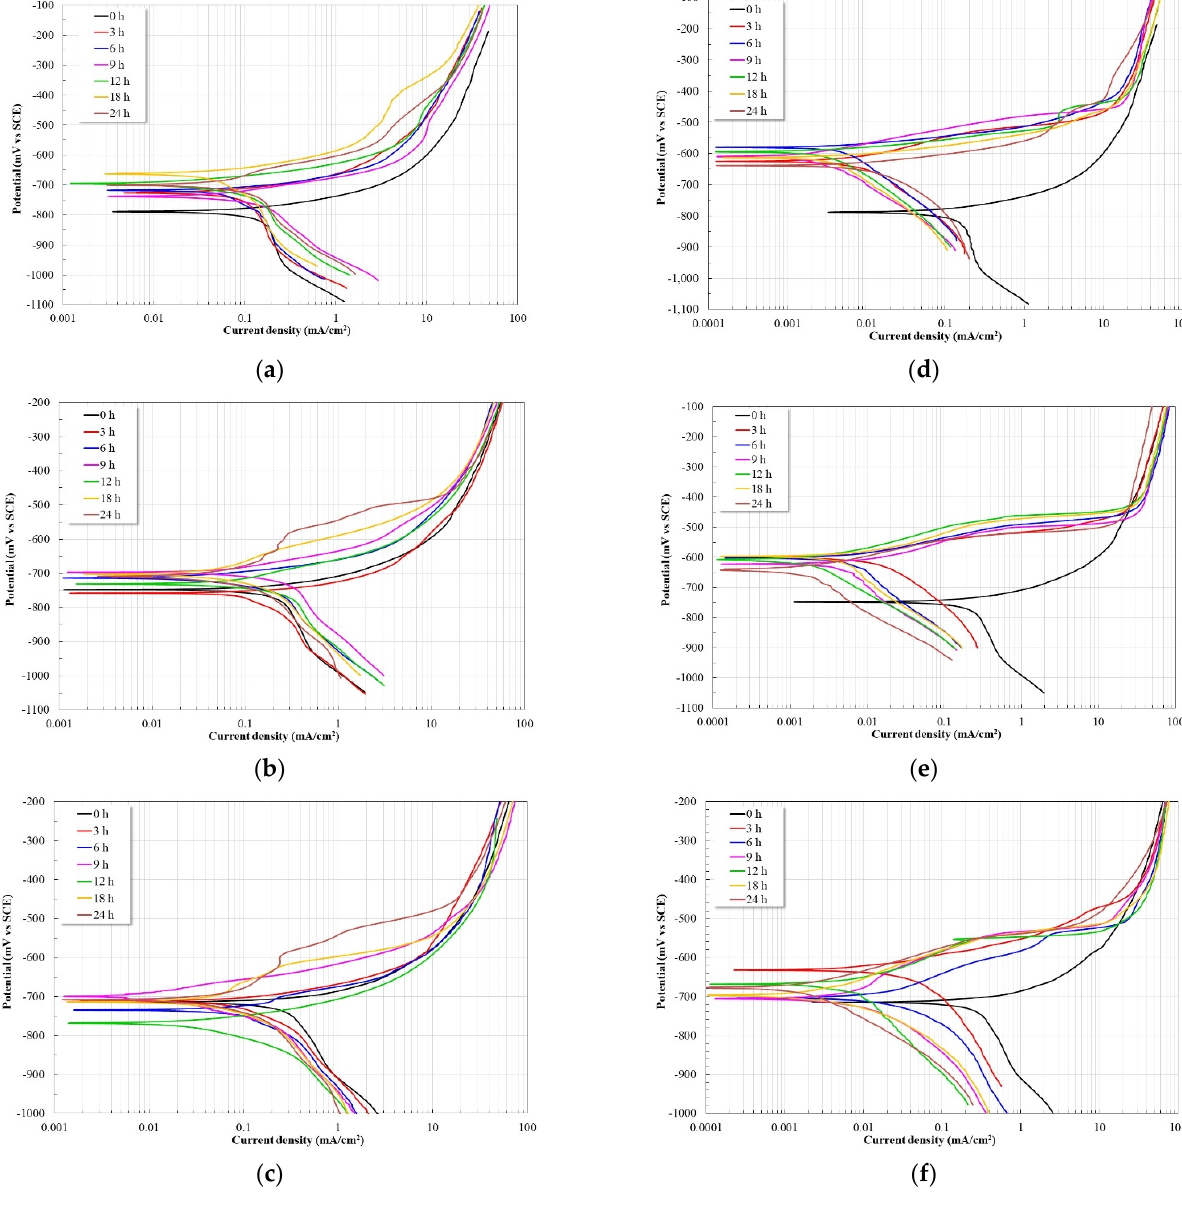
order of magnitude lower). These changes show that the inhibitor has adsorbed on the surface of the working electrode acting as a barrier between the electrolyte and the metal surface, since both the anodic and cathodic currents have decreased. However, even though the anodic branch shows an increase in its slope, it is observed that with an in- crease of around 100 mV with respect to the corrosion potential, large increases in current density are generated. This is possibly due to detachment of the inhibitor due to low ad- sorption forces. On the other hand, at 60 °C (Figure 11e), once again it is observed that after 3 h of immersion, the polarization curves show a shift to more noble potentials (around 100 to 150 mV with respect to Ecorr), and at lower current densities (about two